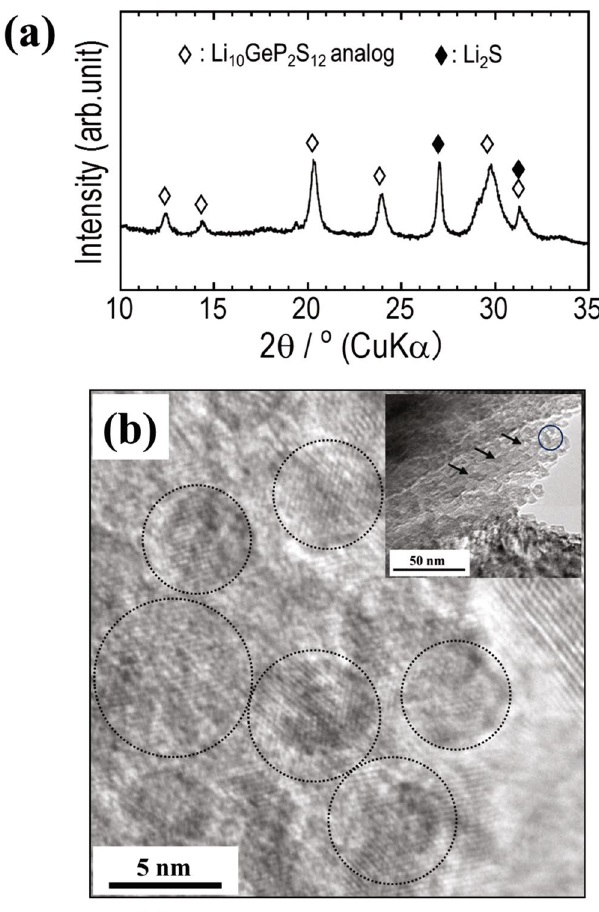
Figure 1. ( a ) The XRD pattern of the 80Li 2 S·20P 2 S 5 glass ceramics obtained by heat treatment. ( b ) HR-TEM image indicating the microstructure of the 80Li 2 S·20P 2 S 5 glass ceramics, together with a BF image in the inset. The image was obtained from the area indicated by the blue circle in the BF